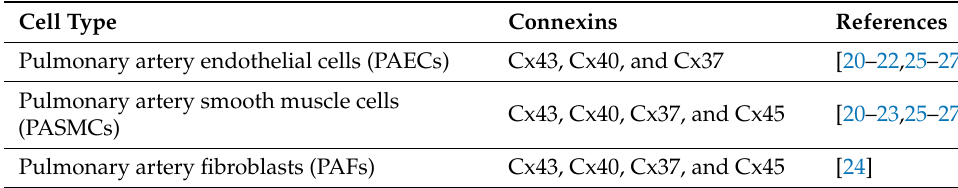
Table 2. Expression of connexins in cells of the pulmonary